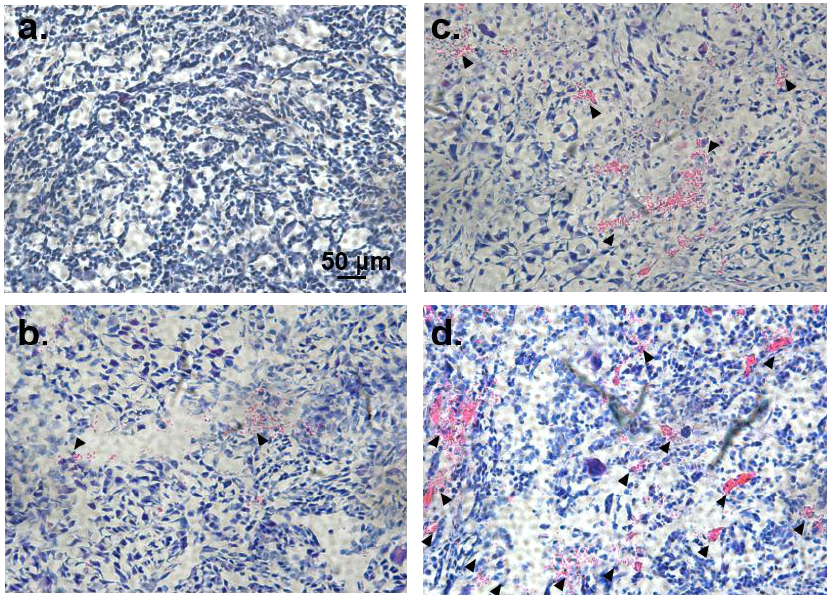
Figure 11. Tumours in mice treated with ( a ) normal saline (control group), ( b ) pristine 25 wt % P2 thermogel (PEG-PPG-PTHF), ( c ) Dox-only (Dox) and ( d ) Dox-loaded P2 thermogel (PEG-PPG-PTHF- Dox) were frozen-embedded and sliced into sections, and then subjected to hematoxylin and eosin staining. Arrows indicate the inflammatory cells and necrosis areas. Scale bar is 50